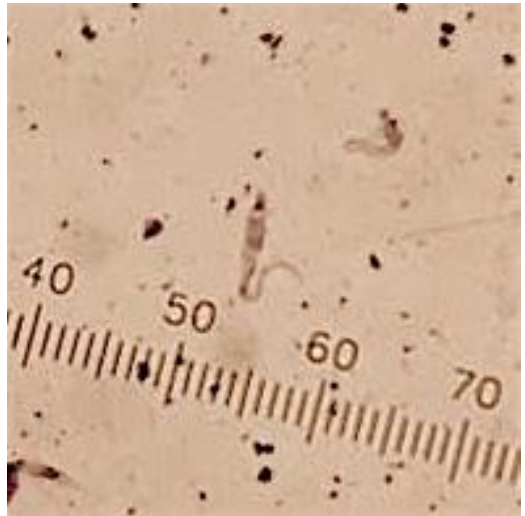
Figure 3. Giemsa stain of T. cruzi isolated from P. geniculatus collected in this study. Scale shown is in μm. Photo: J. K. Peterson.